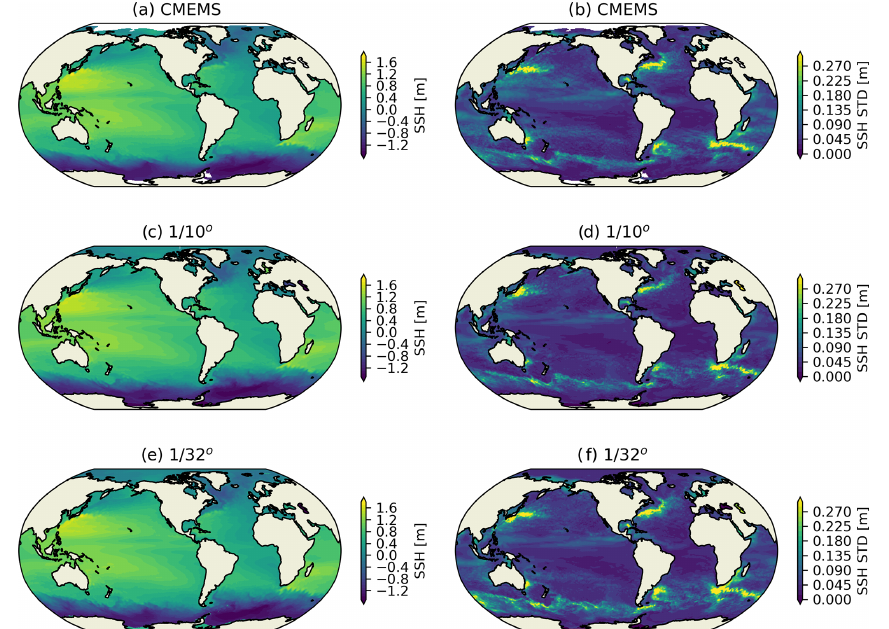
Figure 3. Mean SSH (a, c, e) and SSH SD (b, d, f) based on altimeter observations of CMEMS (a, b) , FIO-COM10 (c, d) and FIO-COM32 (e, f) simulations.